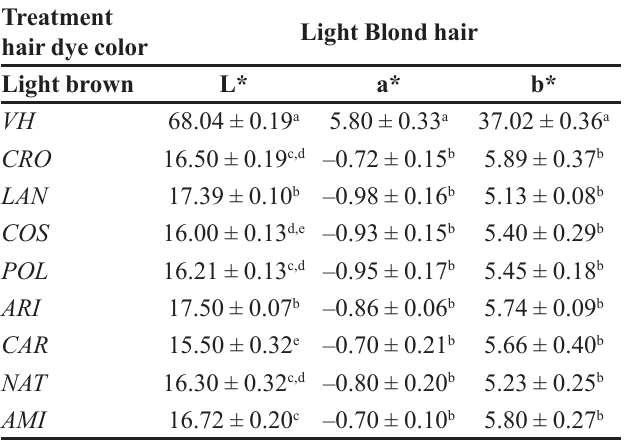
Results categorized with different letters presents as statistically and significantly different, for α = 5, p < 0.05, n = 5. L*: brightness parameter; a*: parameter of color in the red-green coordinate; b*: parameter color of yellow-blue coordinate. VH: Virgin Hair; CRO: Cetearyl Alcohol (and) Dicetyl Phosphate (and) Ceteth-10 Phosphate/ Crodafos TM CES; LAN: Cetearyl Alcohol (and) Sodium Lauryl Sulfate (and) Sodium Cetearyl Sulfate / Lanette N TM ; COS: Cetearyl Alcohol (and) Ceteareth-20/ Cosmowax J TM ; POL: Cetearyl Alcohol (and) Polysorbate 60/ Polawax NF TM ; ARI: Ammonium Acryloyldimethyltaurate (and) VP Copolymer/ Aristoflex avc TM ; CAR: Carbomer/ Carbopol TM 980 ; NAT: Hydroxyethylcellulose / Natrosol TM ; AMI: Sclerotium gum/ Amigel TM